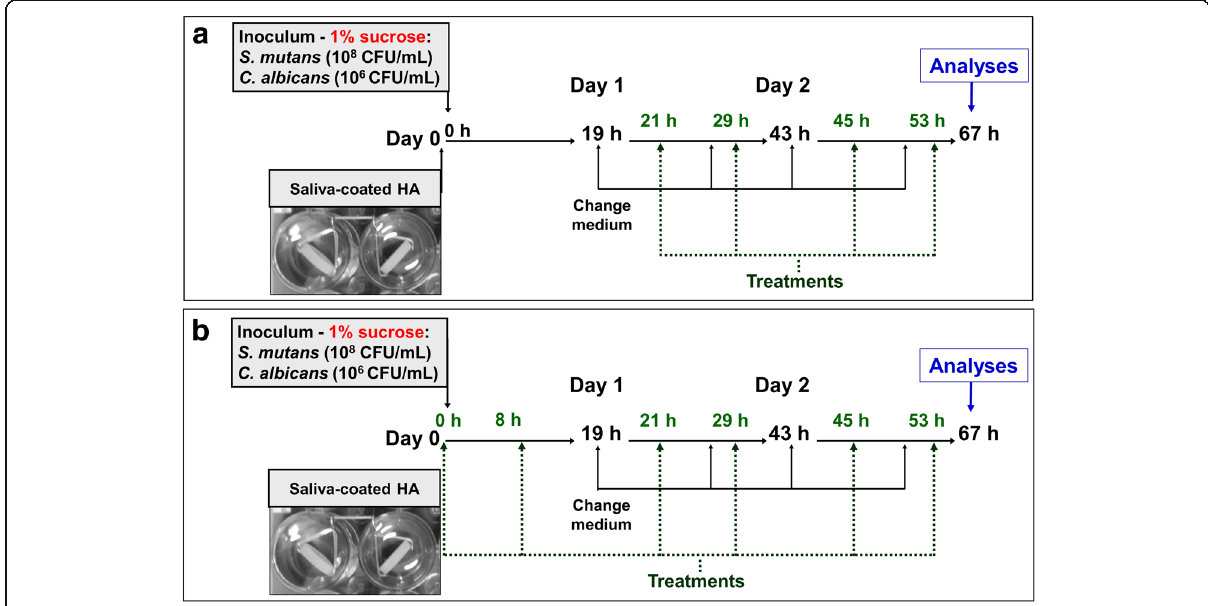
Fig. 1 Treatment regimens used for topical application. a Depicts the regimen one used to accesses the effect on pre-formed biofilms (treatments application starts at 19 h of biofilm development). b Depicts the regimen two used to evaluate the effect on biofilm assembly and accumulation (treatments application on saliva-coated hydroxyapatite discs before microbial